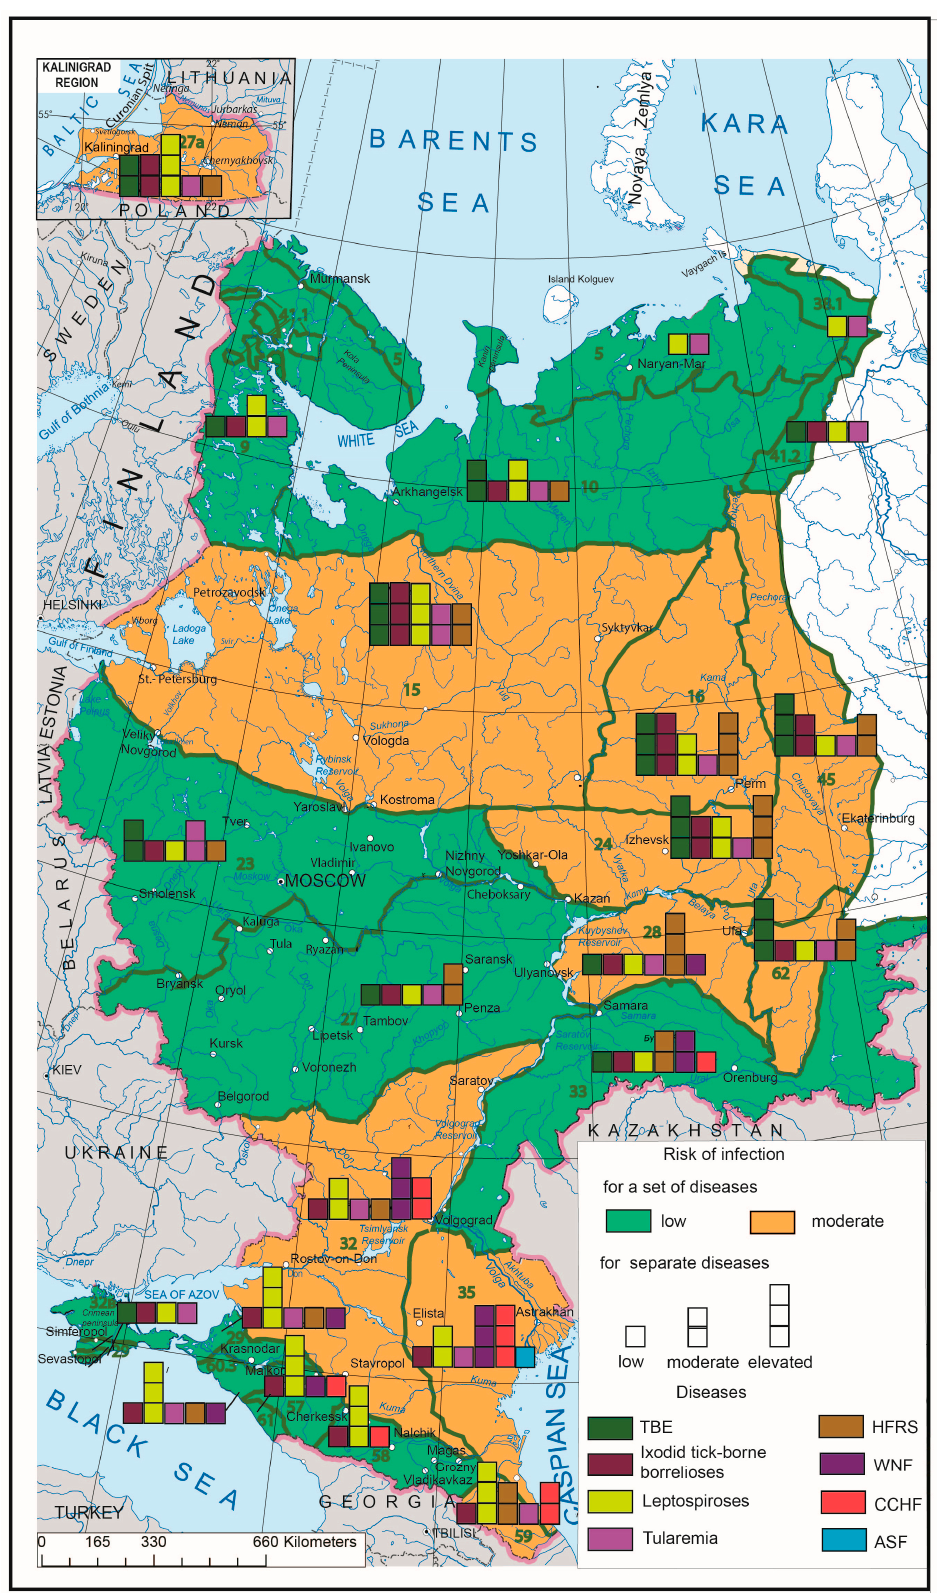
Figure 5. Complex model of emerging infectious disease (EID) risk assessment by biomes. Green lines mark biome boundaries, and green numbers mark biome numbers according to G. Ogureeva